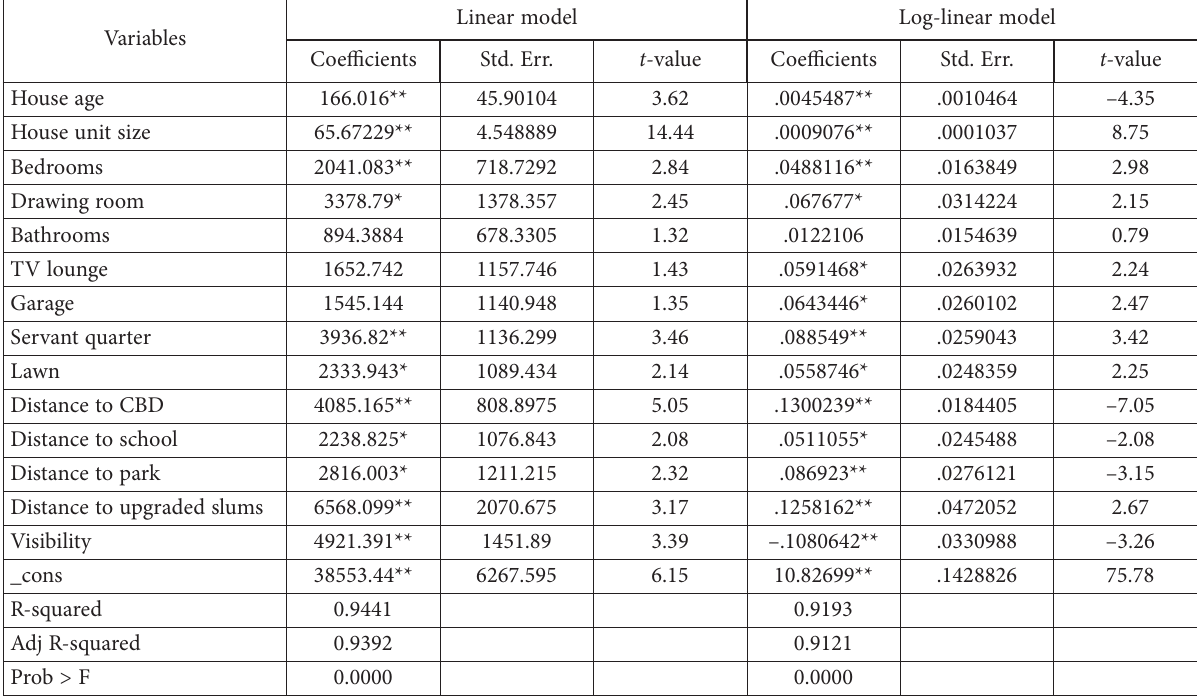
Table 5. Showing estimates of a linear and semi-log model with data from upgraded slums